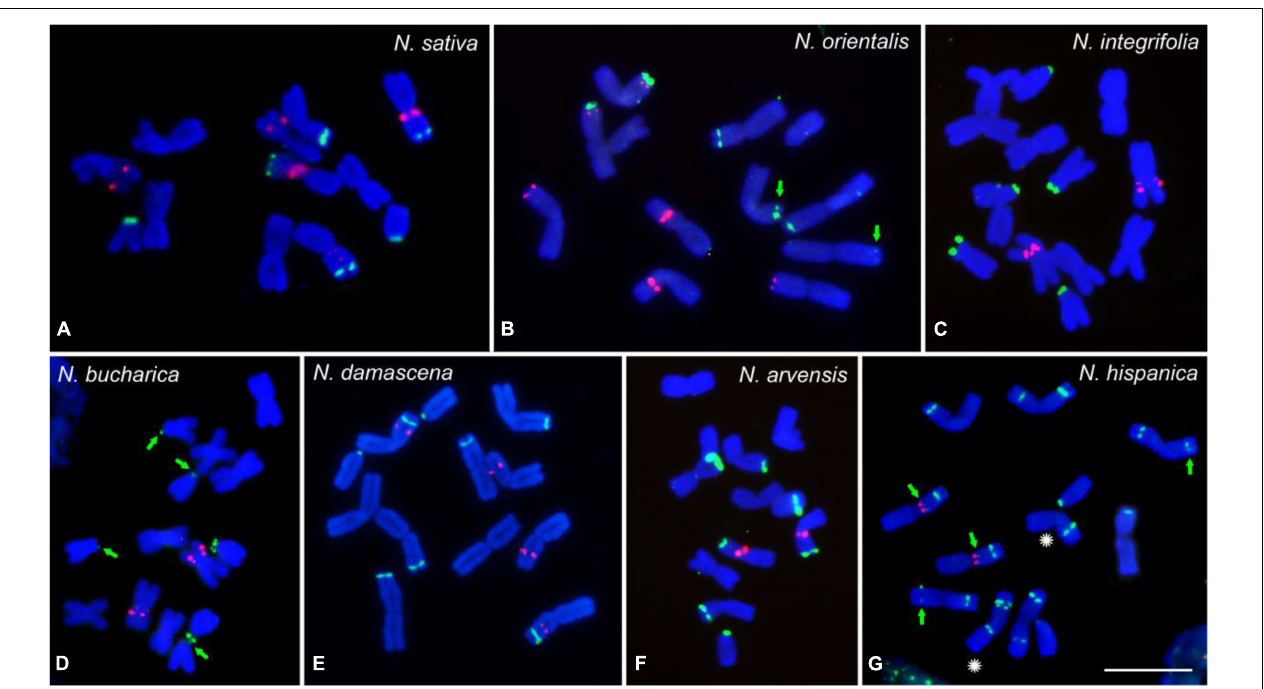
FIGURE 2 | rDNA loci distribution of the studied Nigella species. FISH mapping of 45S rDNA (green) and 5S rDNA (red) on mitotic metaphase chromosomes of N. sativa (A) , N. orientalis (B) , N. integrifolia (C) , N. bucharica (D) , N. damascena (E) , N. arvensis (F) and N. hispanica (G) . Chromosomes were counterstained with DAPI. Arrows indicate weak 45S rDNA signals and the asterisks indicate the homologous chromosomes with hemizygous locus. Scale bar 10 µ